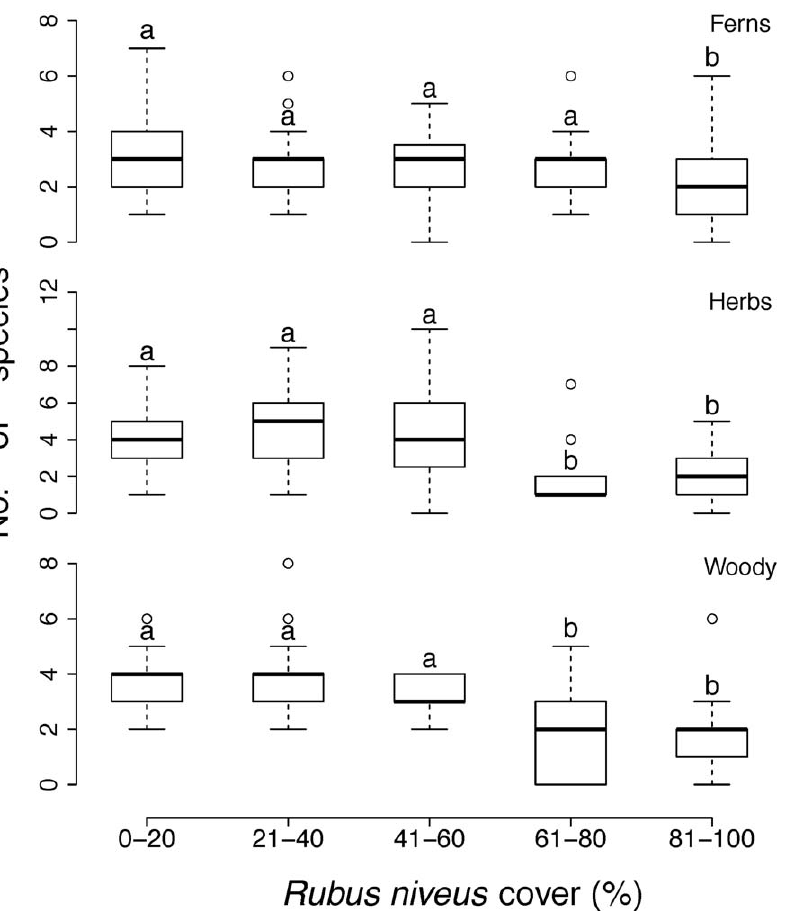
Figure 3. Relationship between R.niveus cover categories and total species richness by growth form (vines are included within herbs and woody species include shrubs and trees) and woody (shrubs and trees). Lines within the box represent the median values of the number of species found within each invasion category; the bottom and top edges of the box represent 25th and 75th percentiles of all data, respectively; the bottom and top bars represent 5th and 95th percentiles. ANOVA-GLM (quasi-Poisson error distribution); ferns: F 4,119 =3.55, P=0.009; herbs: F 4,119 =11.44, P=0.009, woody species: F 4,119 =13.13, P , 0.001 ( a,b denote group differences detected by statistical analyses amongst R. niveus cover